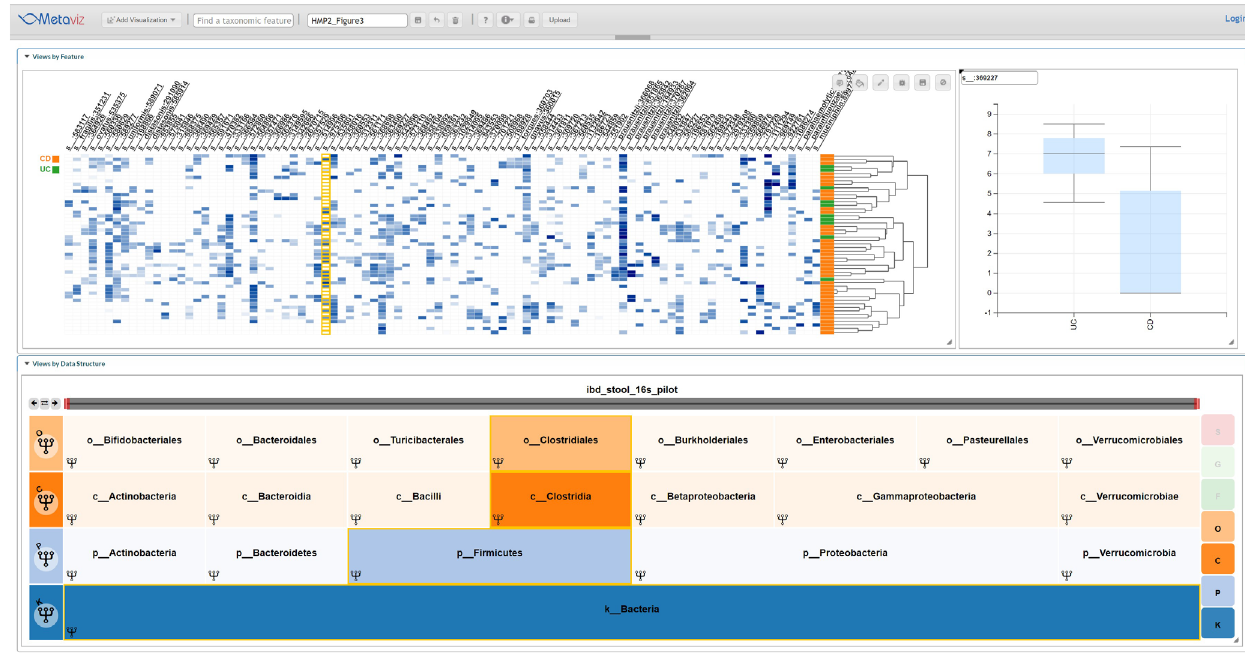
Figure 3. Metaviz Analysis of IBD Stool 16S Pilot Dataset. A Metaviz workspace with a FacetZoom taxonomic hierarchy, heatmap, and boxplot for the specific feature in this instance s__:369227. This identifier was from the community abundance profiles available from the HMP2Data package. We identified taxonomic features at each level of the hierarchy using this integrated view and the results for features with a potential differential abundance are listed in Supplementary Table 1. The workspace is available at: http://metaviz.cbcb.umd.edu/ ?ws=oLq2Fr9AwVc.